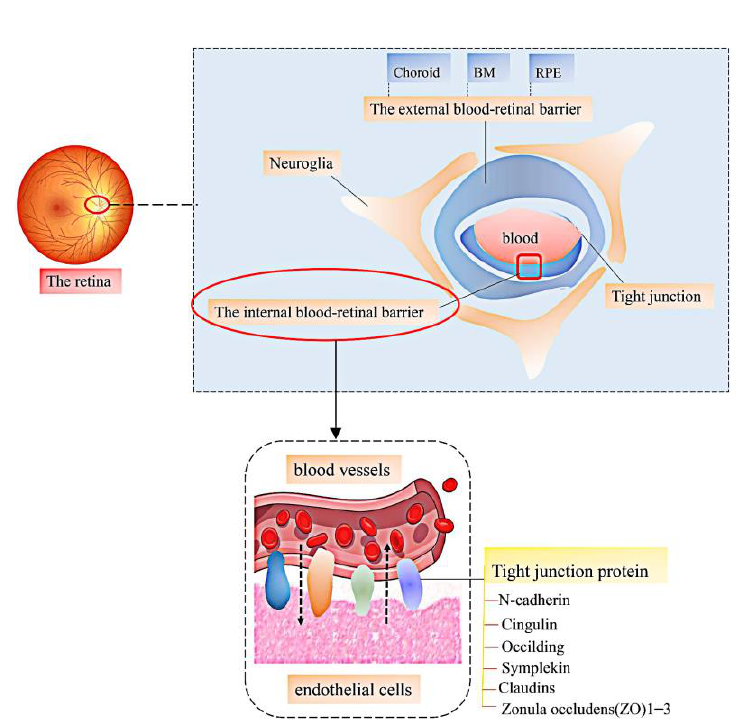
Figure 3. The main pathogenic sites in vascular retinopathy. The physiological connections between the human retina and blood vessels are mainly internal and external blood – retinal barriers, glia, etc. The internal blood – retinal barrier is an important part, and a tight junction protein is the key part of it.